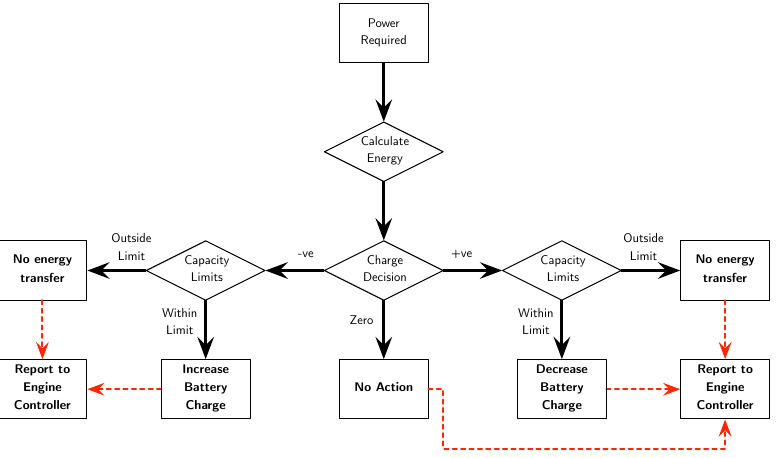
Figure 13. Decision flow chart for the battery